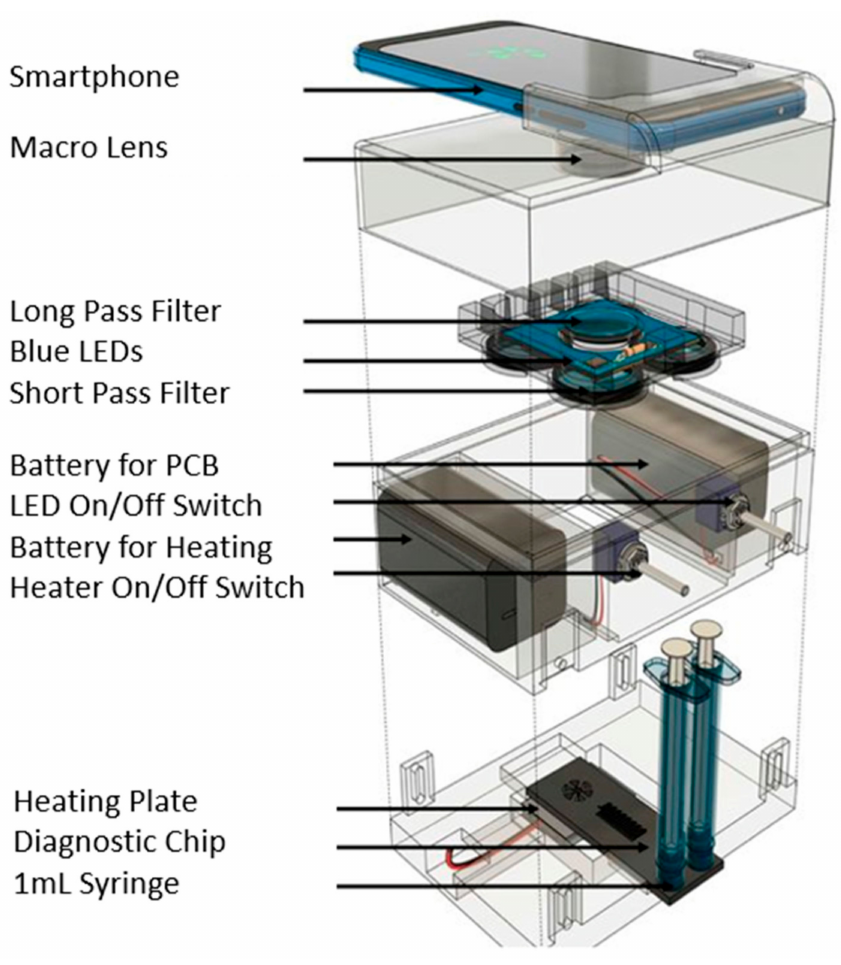
Figure 7. COVID-19 nucleic acid amplification RT-LAMP